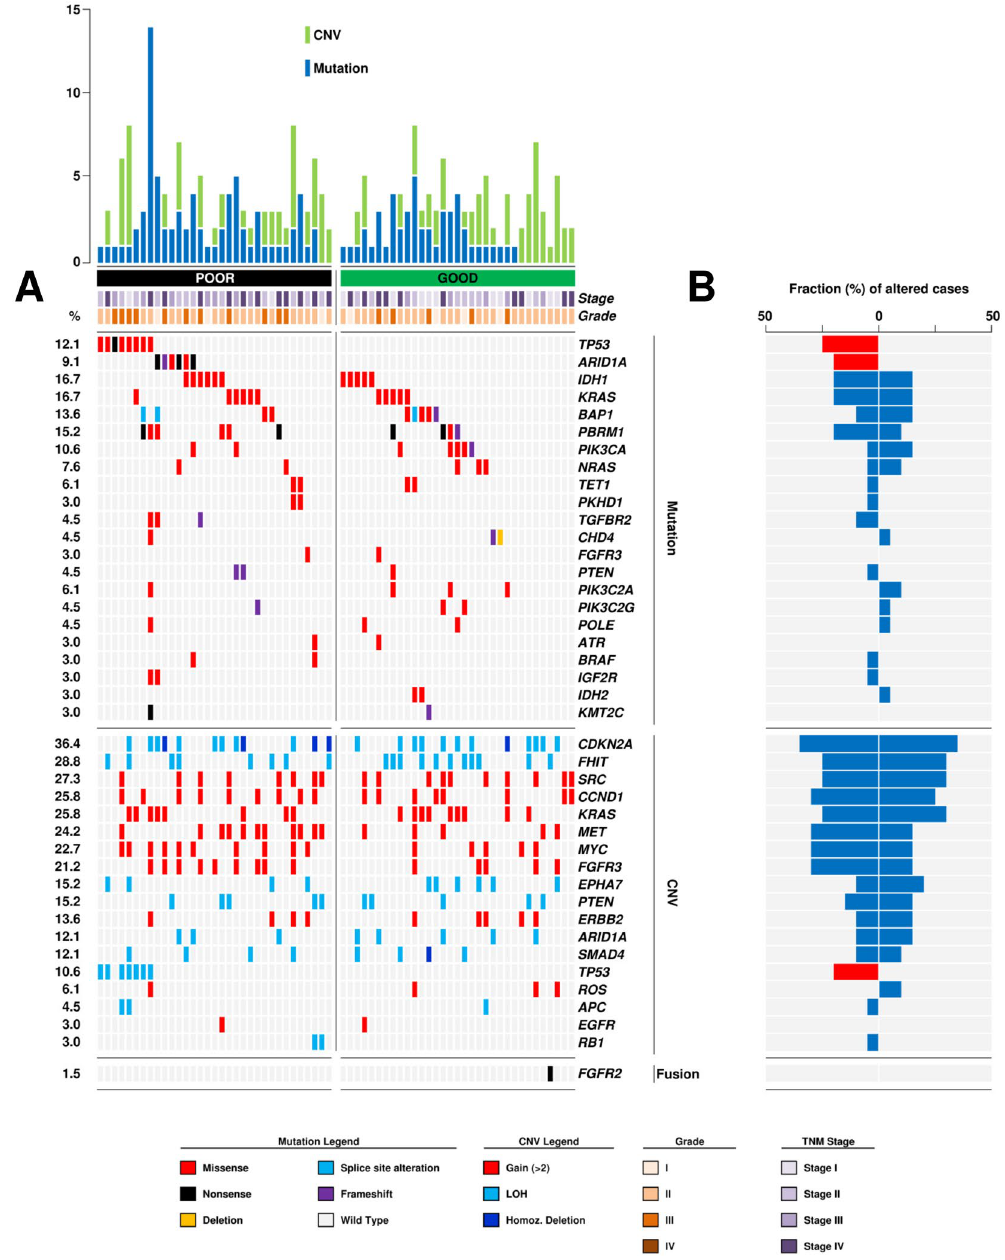
Figure 2. Genetic alterations distinguished two prognostic performer groups. ( A ) Cases are grouped according to prognostic group (poor and good) previous defined by clinical outcome. The upper histogram shows the number of mutations (blue) and CNV (green) in recurrently altered genes for each sample. The central matrix shows 22 genes that were mutated in at least two cases of the whole cohort, 18 genes altered in copy number and 3 genes shown rearrangement; alterations are annotated by different colour according to their impact on the gene product as illustrated in panel below. The number on the left reports the alteration frequency of each gene expressed as a percentage. ( B ) Fraction (%) of cases altered for each gene is represented by blue box or red box (when a statistical significant distribution was observed) according to prognostic group (poor prognosis on the left; good prognosis on the